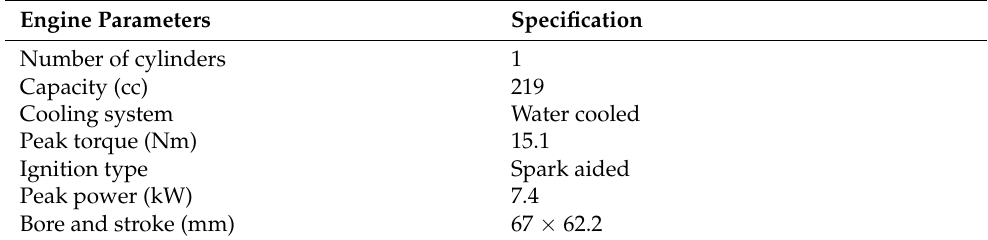
Table 1. Attributes of the 4-stroke heat